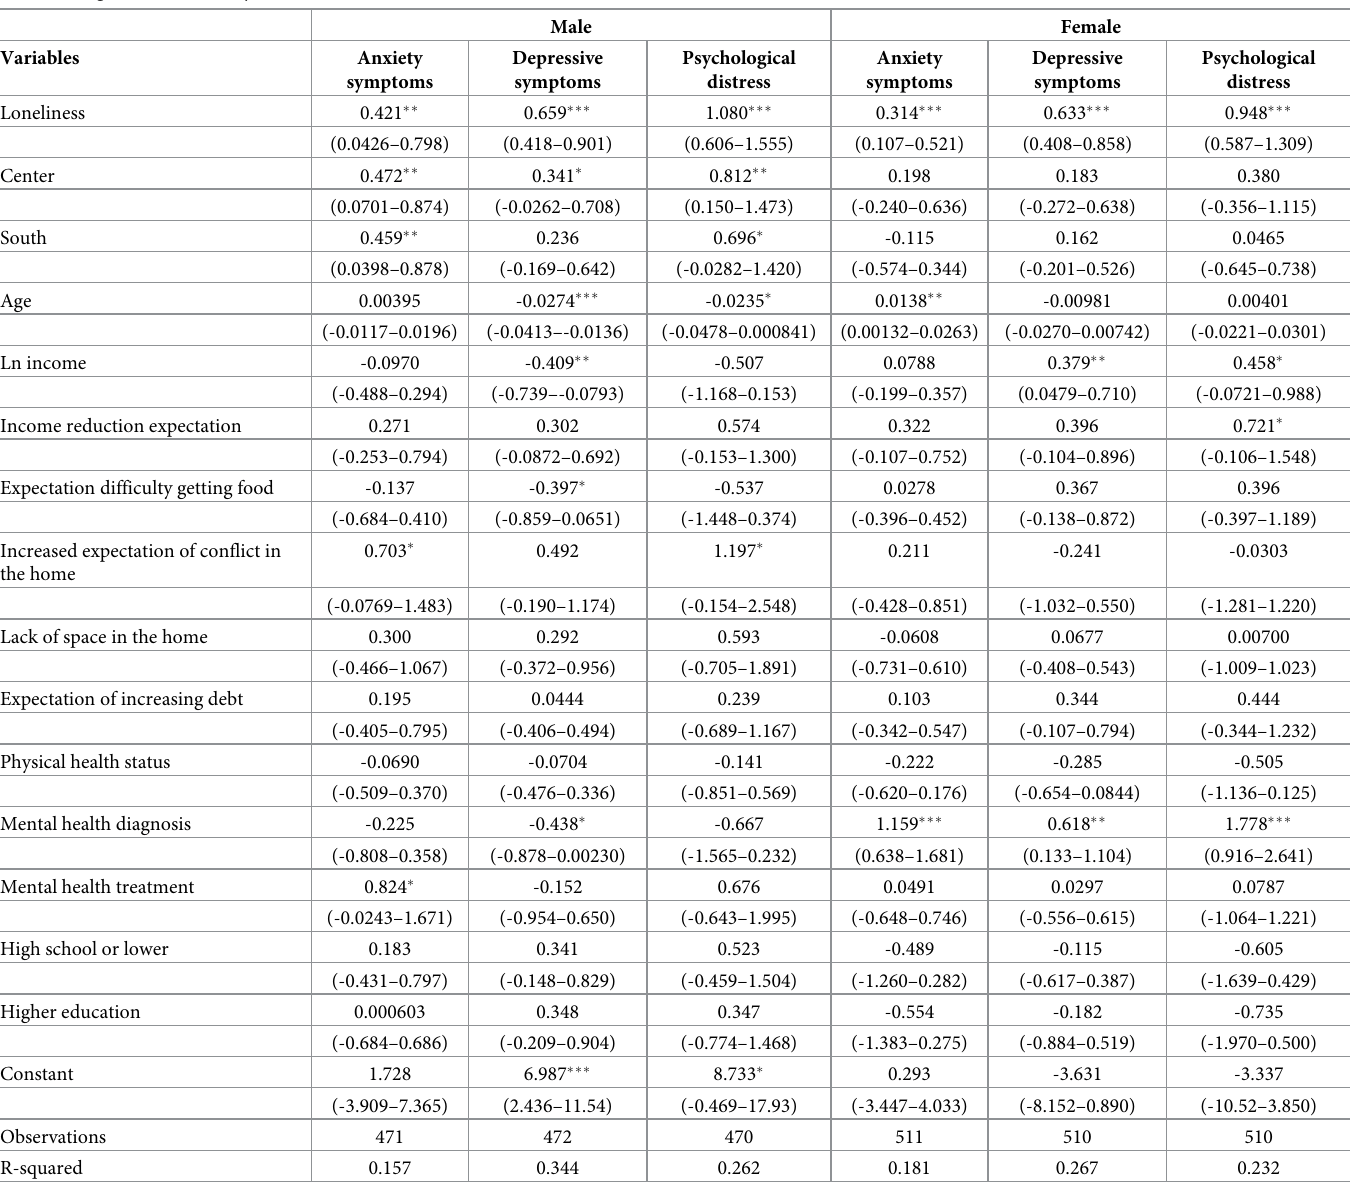
Table 4. Regression models by